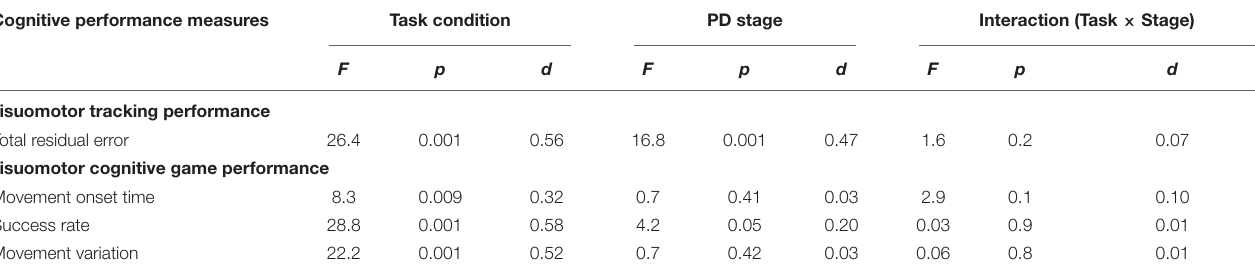
TABLE 5 | Main effects and effect sizes (Cohen’s d ) of task condition and PD severity on the visuomotor tracking (VMT) and visuomotor cognitive game (VCG) outcome measures. Cognitive performance